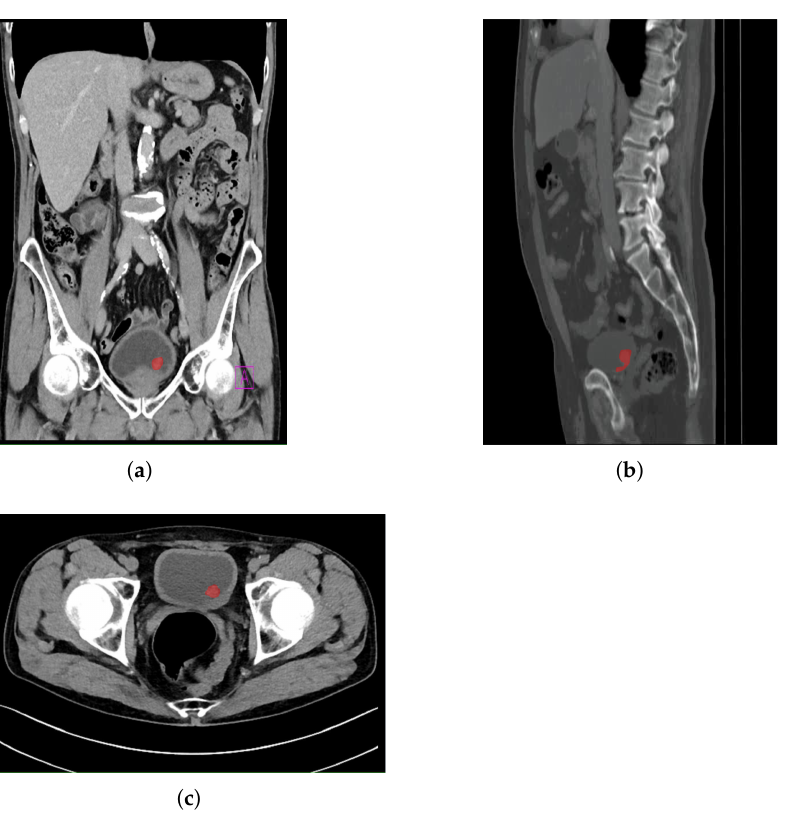
Figure 3. Examples of annotated images used for the creation of output masks: ( a ) frontal plane; ( b ) sagittal plane; and ( c ) axial